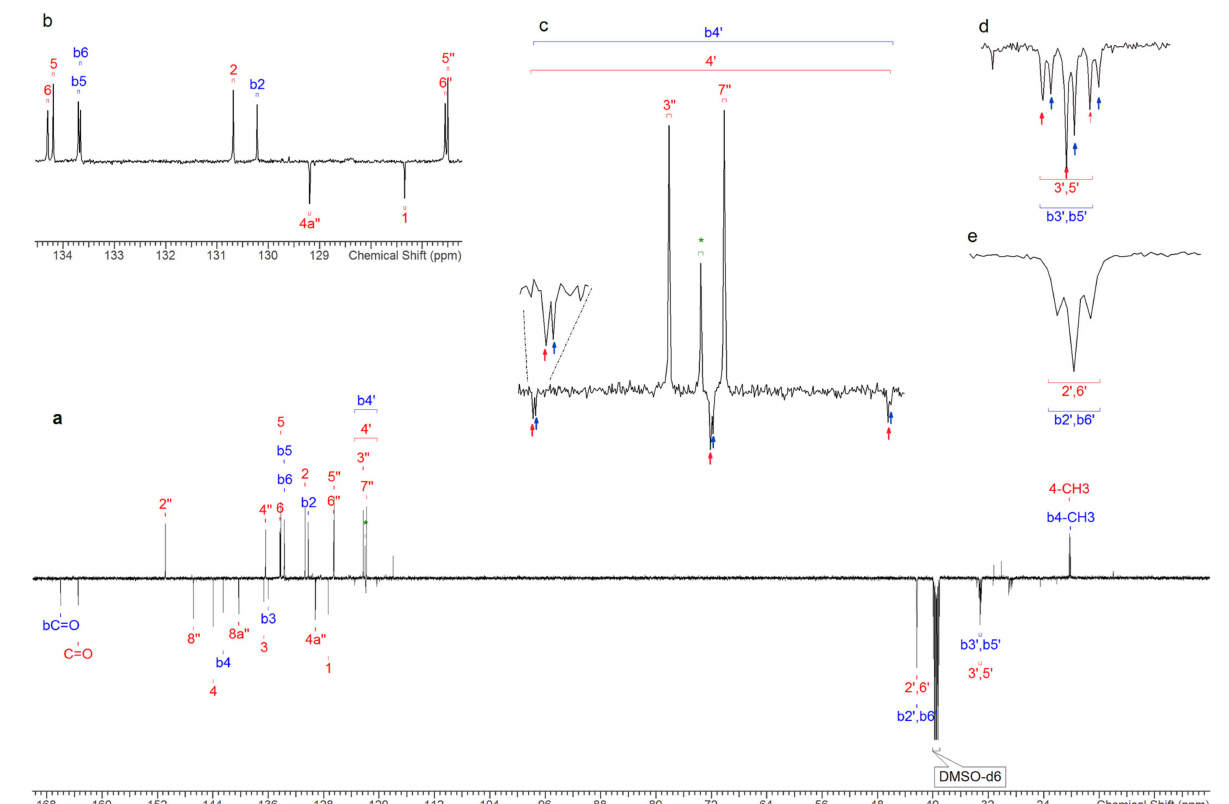
Figure 3. ( a ) 13 C APT NMR spectrum of 2F-QMPSB in DMSO-d 6 (sample 7); ( b ) expansion of a part of the aromatic region; ( c ) expansions showing triplets 1 J C-F = 241 Hz from carbons 4’ and b4’ of the two identified compounds, the peak ( δ = 122 ppm) assigned with an asterisk ( * ) is from an unidentified secondary species; ( d ) triplets 2 J C-F = 23.2 Hz of 3 (cid:48) ,5 (cid:48) and b3 (cid:48) ,b5 (cid:48) and ( e ) overlapping triplets 3 J C-F = 5.5 Hz for 2’,6’ and